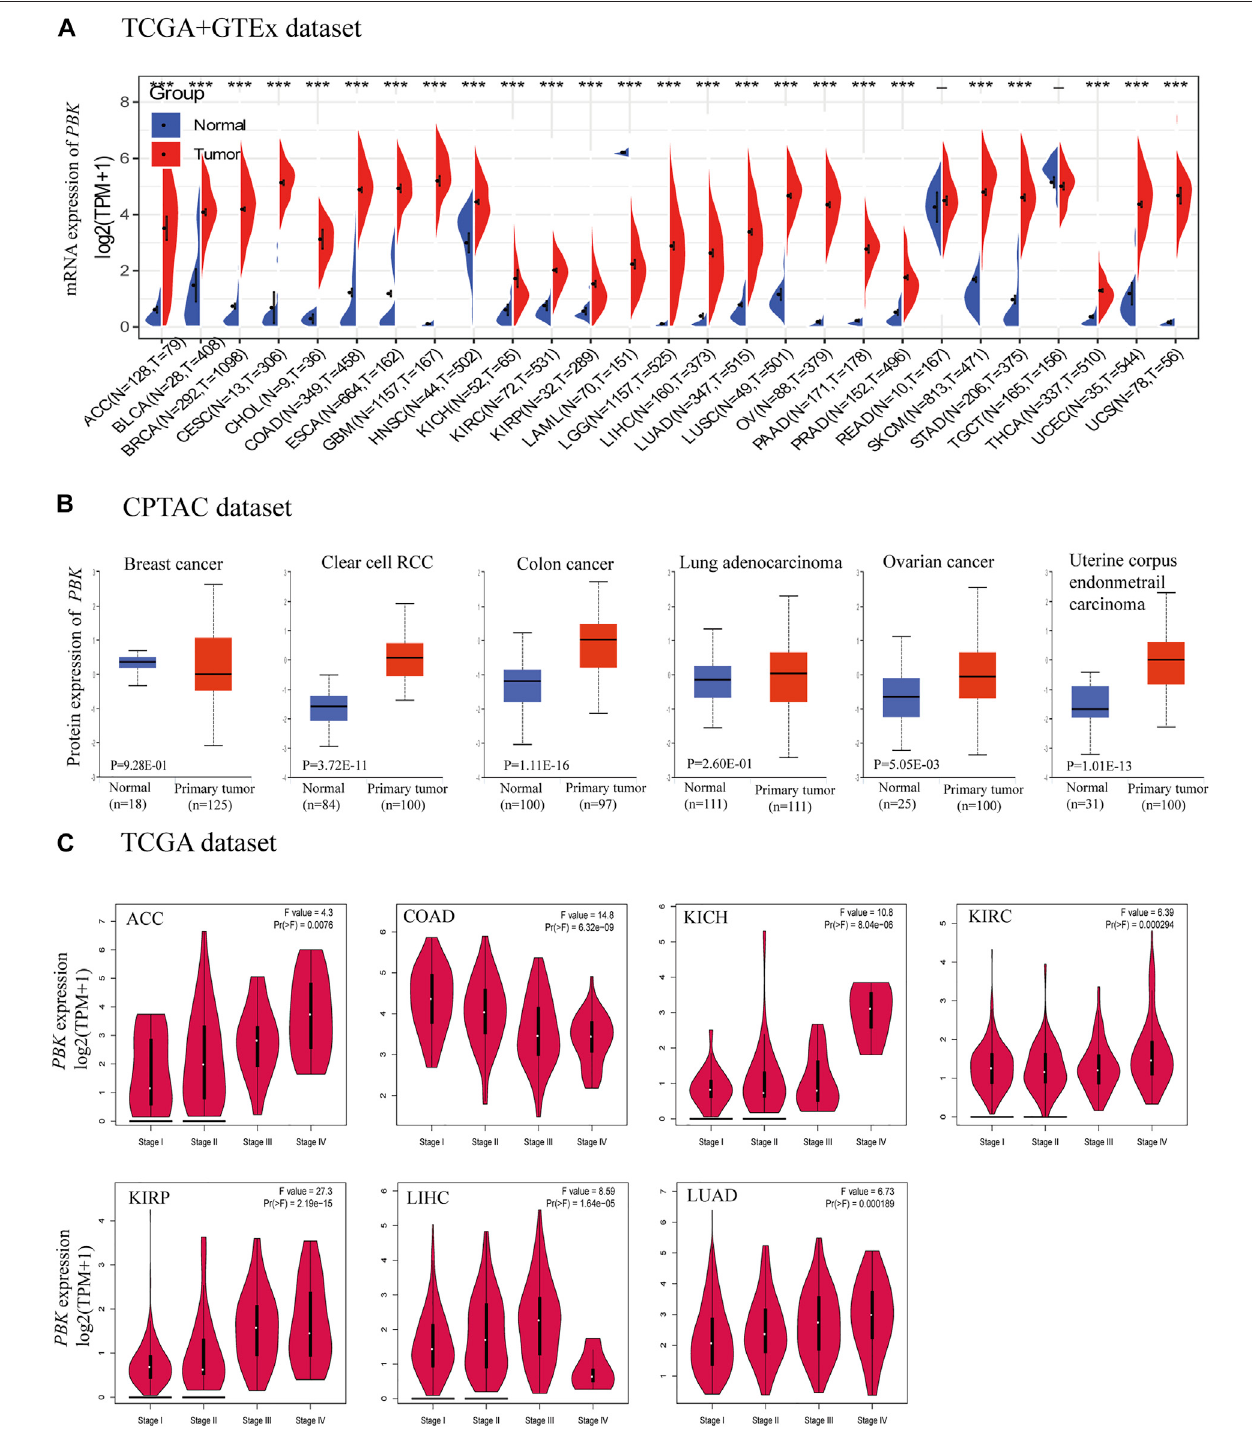
FIGURE 1 | PBK expression. (A) Expression of PBK in tumor and normal tissues in TCGA + GETx dataset. (B) PBK protein level in tumor tissues compared to normal tissues. (C) PBK expression in different stages of ACC, COAD, KICH, KIRC, KIRP, LIHC, and LUAD.